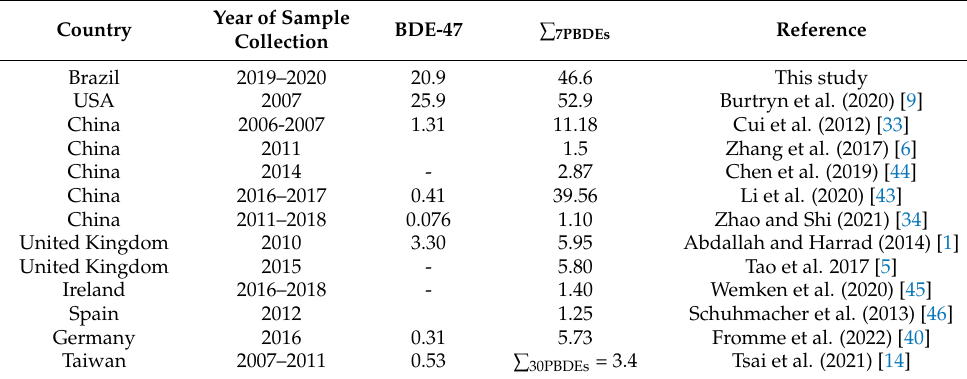
Table 4. Comparison with studies reported in the literature in other countries. The values are expressed as ng/g lipid.